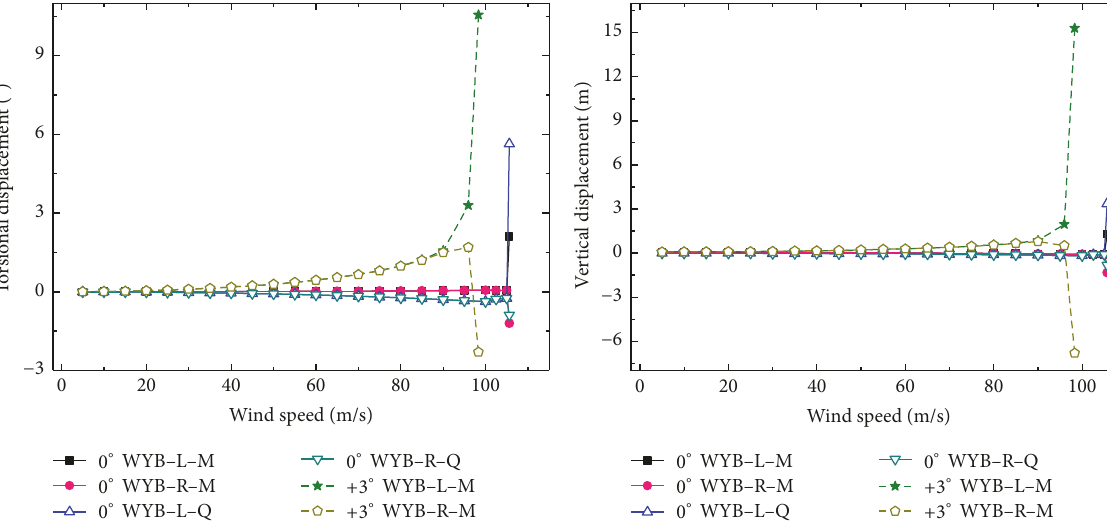
Figure 9: The torsional and vertical displacements for WYB with initial attack angles of 0 ∘ and +3 ∘ . L: left; R: right; M: midspan point; Q: quarter-span